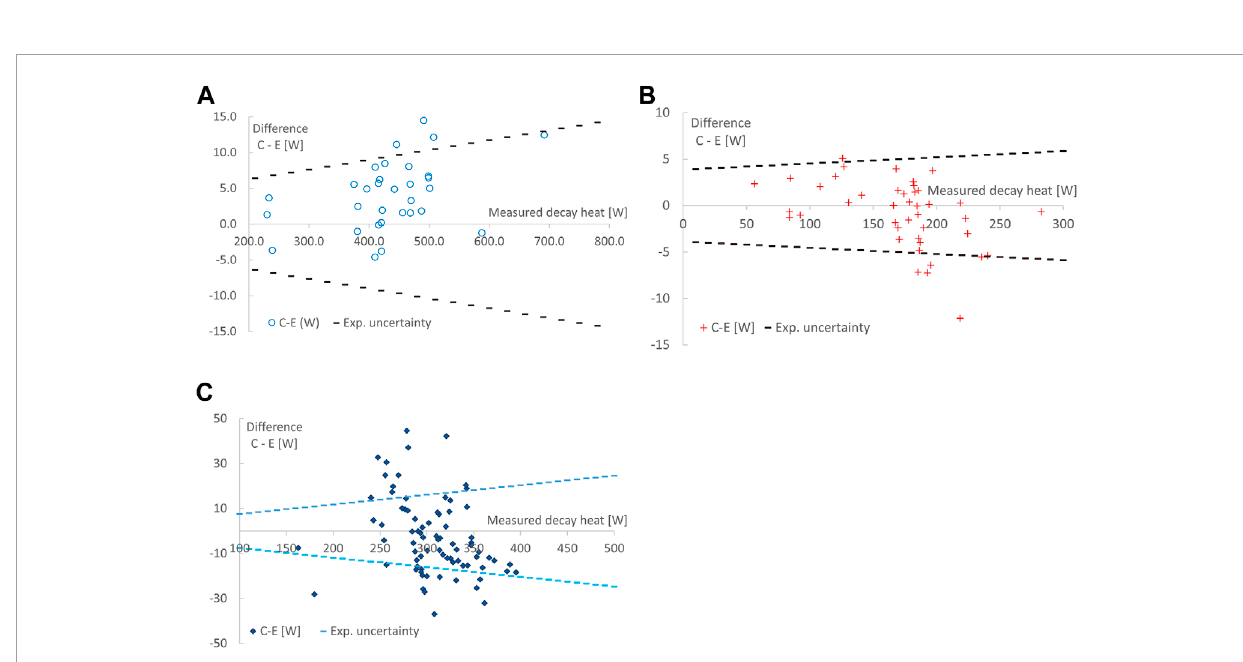
FIGURE 4 Difference between calculation and measurement C-E in W. The dashed straight lines represent the reported measurement uncertainties of the corresponding sample set. (A) PWR samples (CLAB data). (B) BWR samples (CLAB data). (C) BWR samples (Cooper, GE-Morris data).